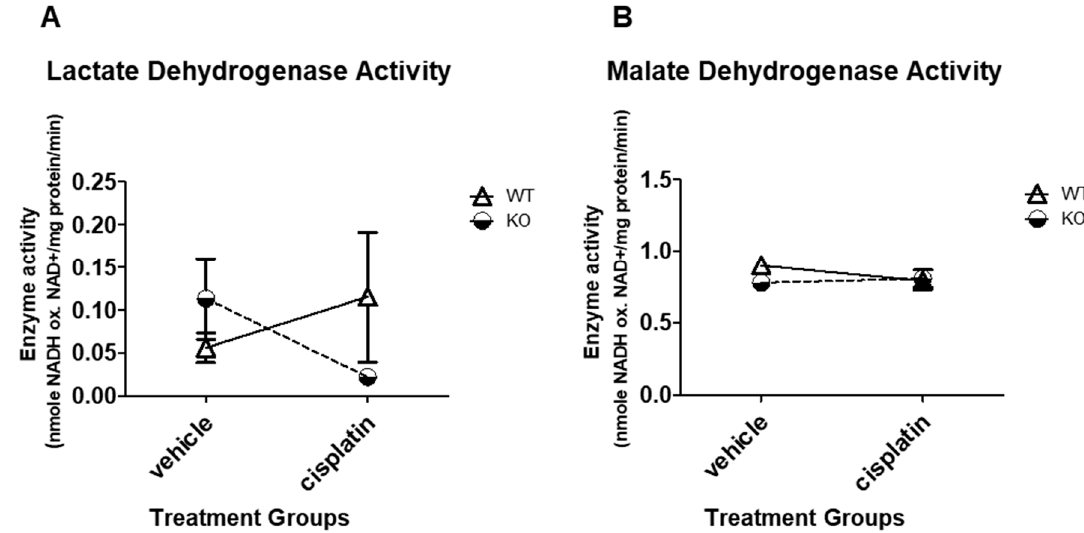
Figure 2. Lactate dehydrogenase and malate dehydrogenase enzyme activity in WT and NHERF1 KO mouse kidneys. Two to 4-month-old male C57BL / 6J WT and NHERF1 KO mice were given cisplatin (20 mg / kg dose IP) or vehicle (saline) and sacrificed after 72 h as described in the Methods section. ( A ) Lactate dehydrogenase (LDH) enzyme activity was determined from kidney cortex tissue of these mice. Data are mean ± SEM (WT vehicle n = 3), (KO vehicle n = 4), (WT cisplatin n = 3), and (NHERF1 KO cisplatin n = 5). No significant di ff erences were recorded. ( B ) Malate dehydrogenase (MDH) enzyme activity was determined from the kidney cortex tissue of these mice. Data are mean ± SEM (WT vehicle n = 3), (KO vehicle n = 4), (WT cisplatin n = 3), (NHERF1 KO cisplatin n = 5). No significant